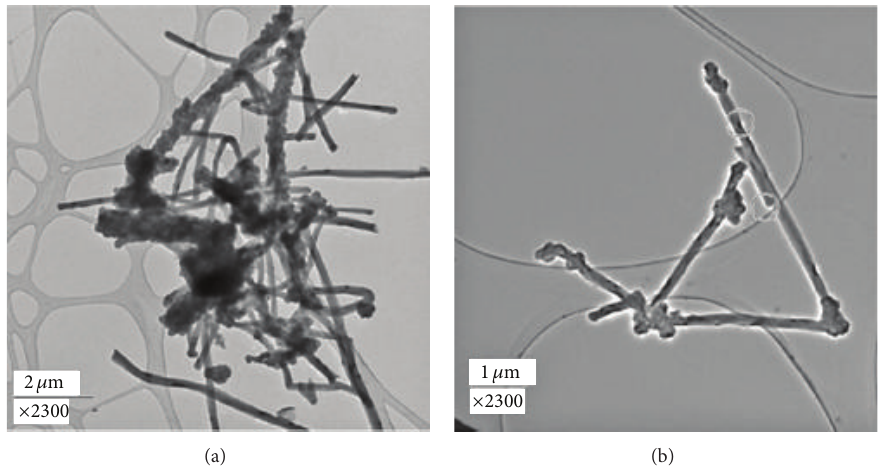
Figure 3: The effect of ultrasonication on dispersion of MWCNTs